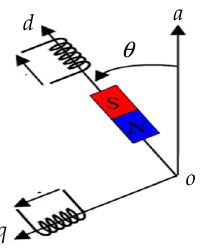
Figure 1. Descriptive diagram of DMC fed PMSM drive system.